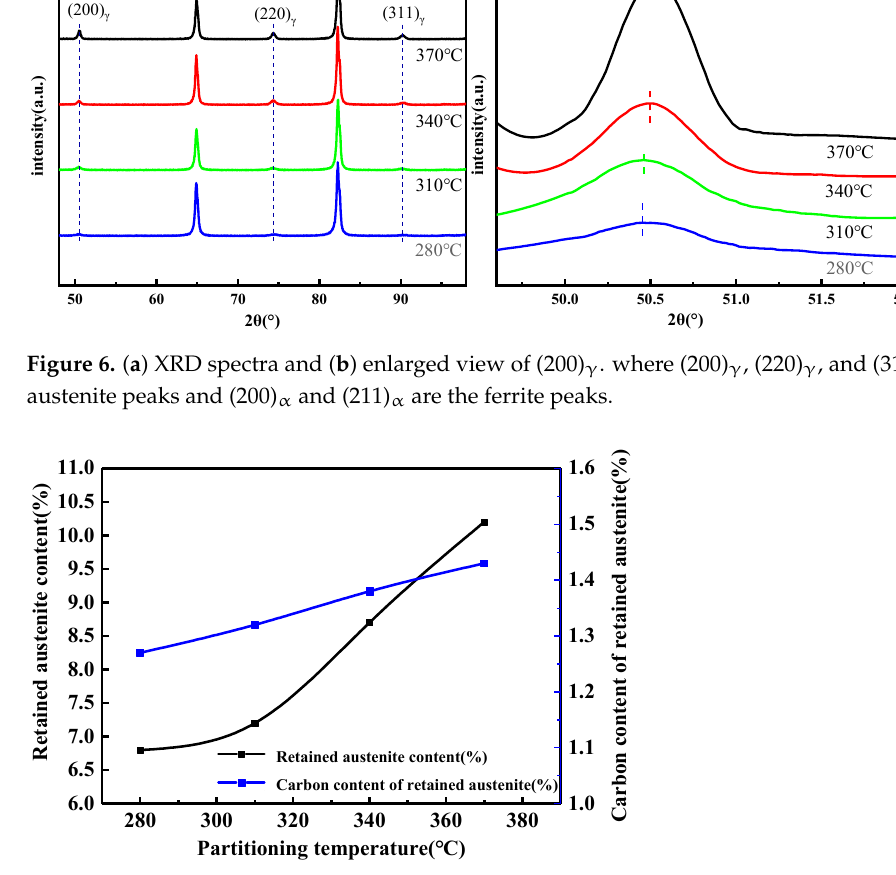
Figure 7. Relationship between RA fraction, carbon content and partitioning temperature.